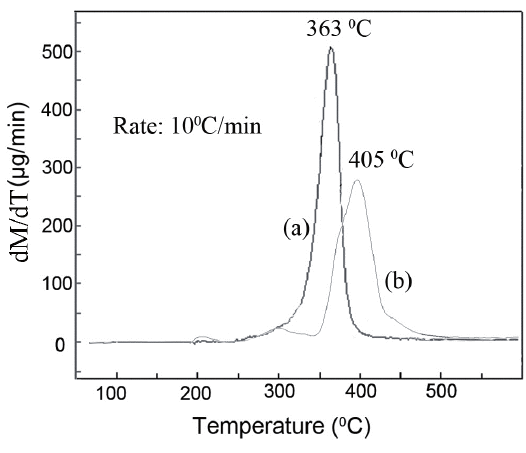
Figure 17. DTG curves of (a) CA, (b) CA/Sb 2 O 3 -Br com- pound.